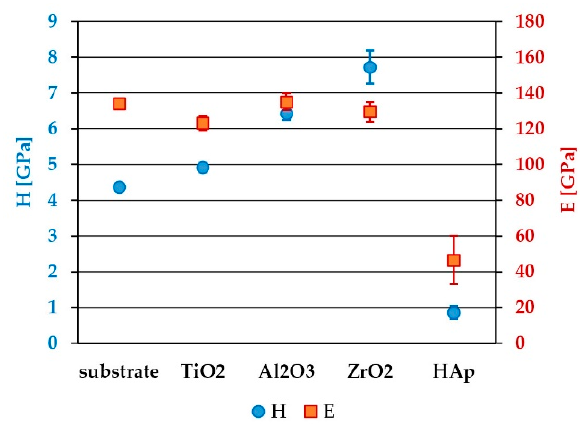
Figure 10. Average values of hardness and elastic modulus for investigated samples.